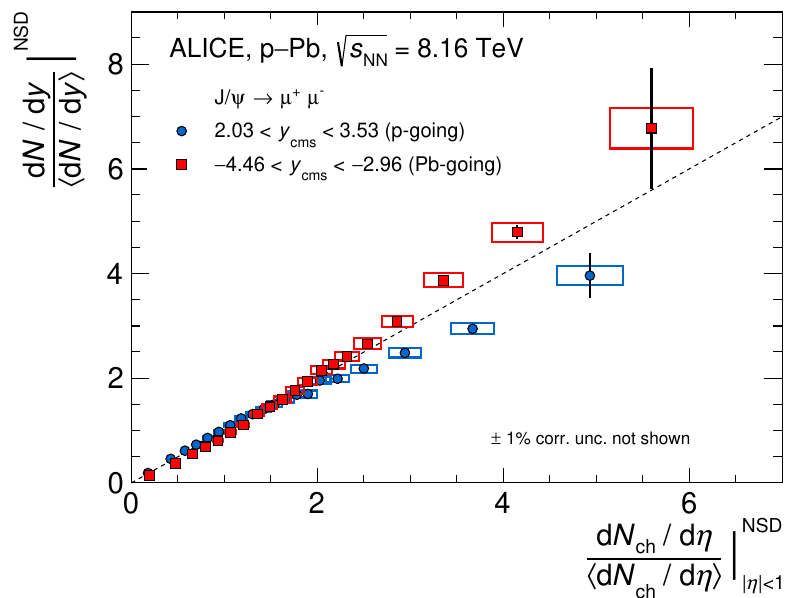
Figure 3 . Normalized yield of inclusive J = , at forward and backward rapidities, as a function of the normalized charged-particle pseudorapidity density, measured at midrapidity, in p-Pb collisions p at s NN = 8 : 16 TeV. The vertical bars represent the statistical uncertainties. The vertical and horizontal widths of the boxes represent the respective systematic uncertainties for the J = yields and the multiplicities. The dashed line indicates the one-to-one correlation, to guide the